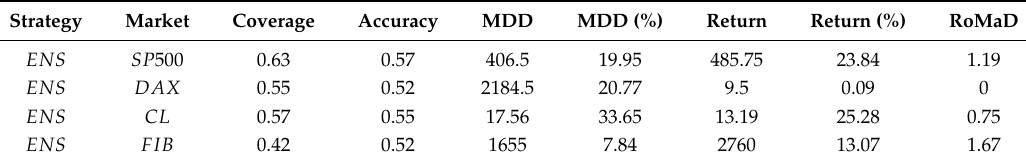
Table 8. Ensemble predictors’ performance after a tuning process optimized by